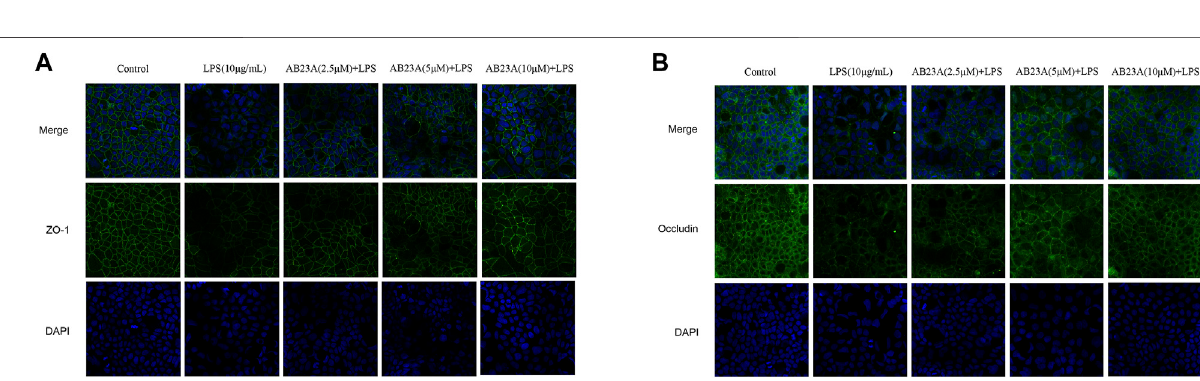
Frontiers in Pharmacology |